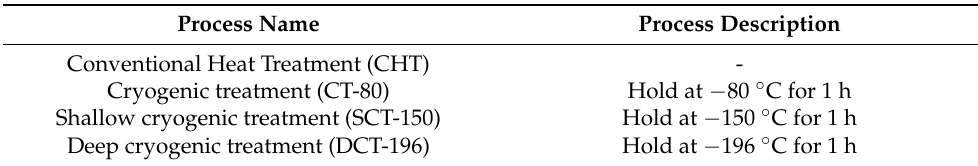
Table 2. Process name and